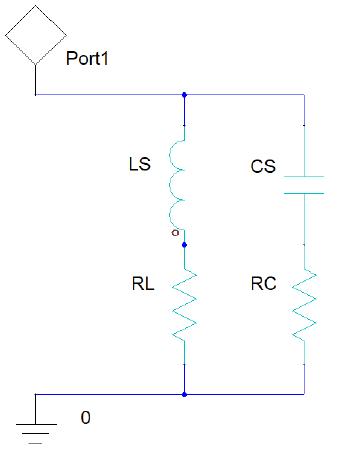
Figure A1. LC parallel circuit characterization of measurement setup at LCR meter used for measuring series capacitance and resistance for